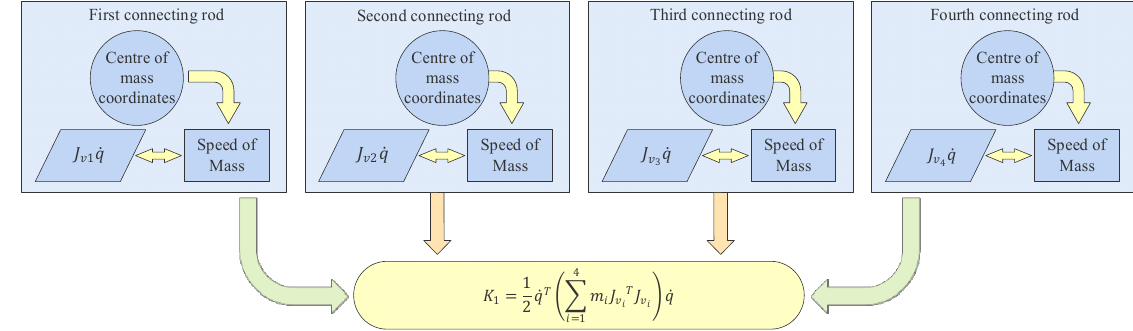
Figure 4. Calculation of translational partial kinetic